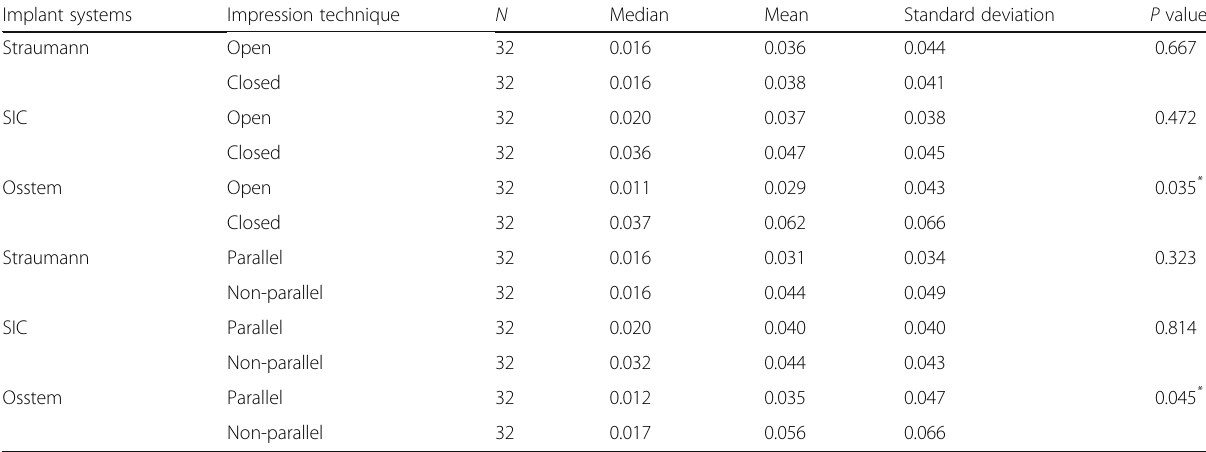
Table 2 Accuracy of impression technique for parallel and non-parallel implant systems Implant